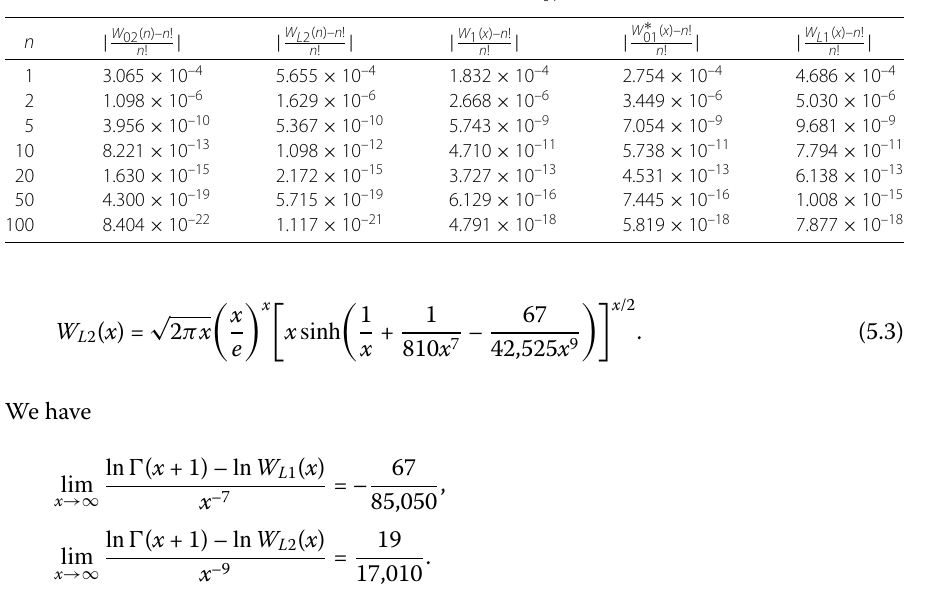
Table 1 Comparison among W 02 (1.9), W L 2 (5.3), W 1 (1.3), W ∗